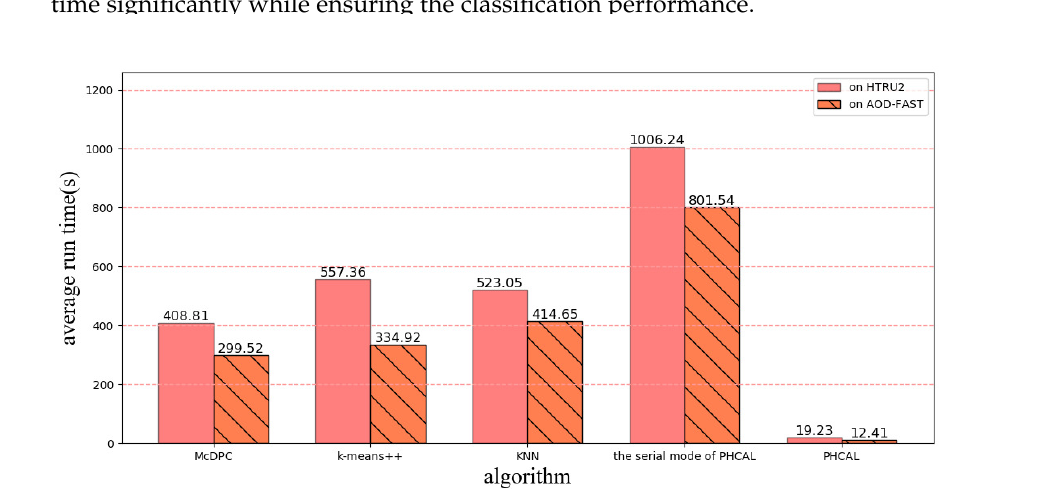
Figure 5. Average running time of PHCAL and other